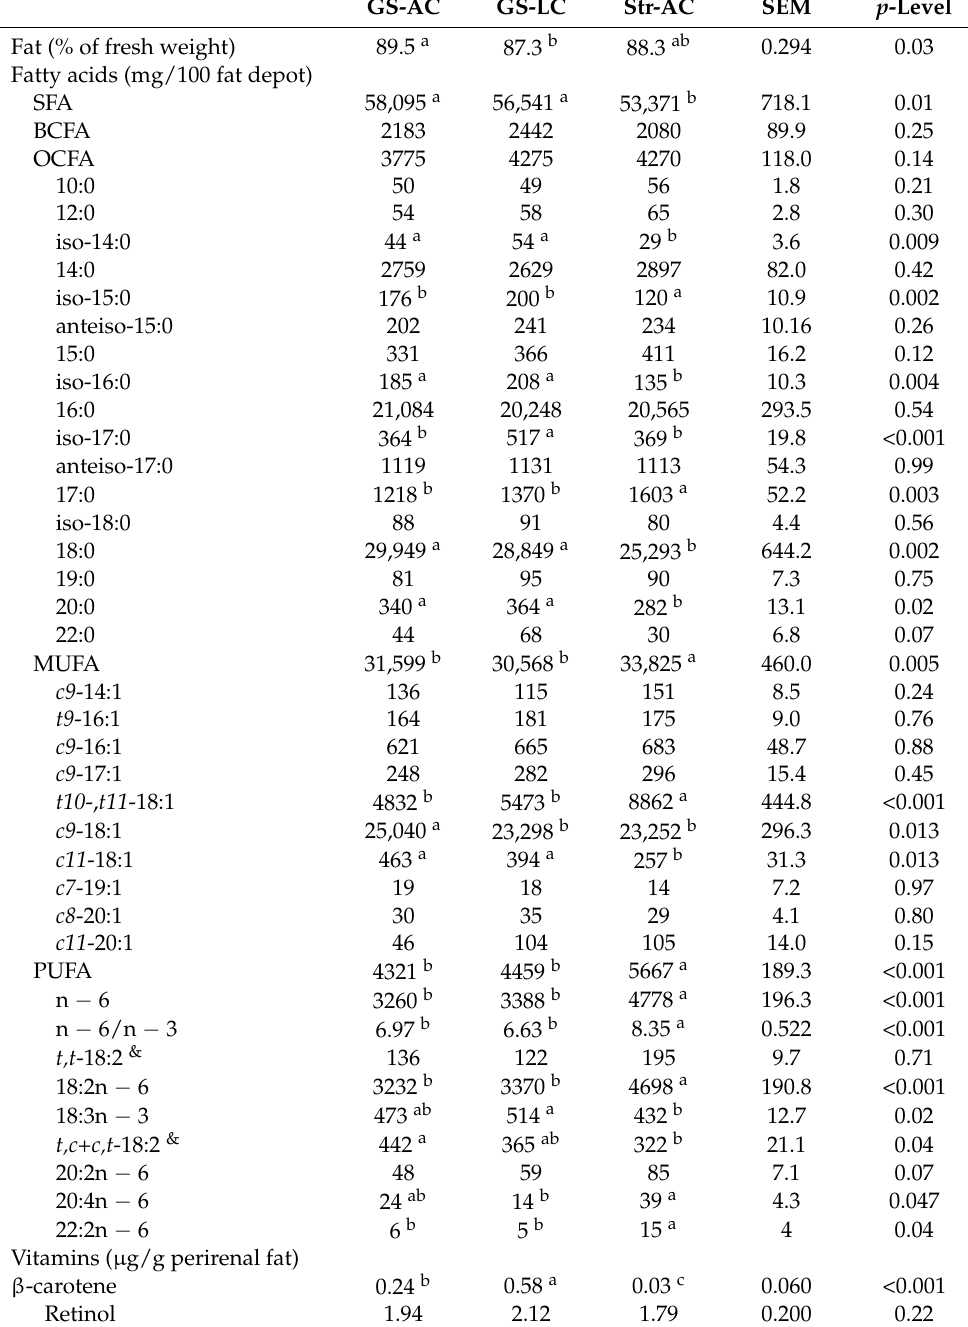
Table 4. Fat content, fatty acid (FA) profile, and fat-soluble vitamins in the perirenal fat depot of young Tudanca bulls reared under different feeding